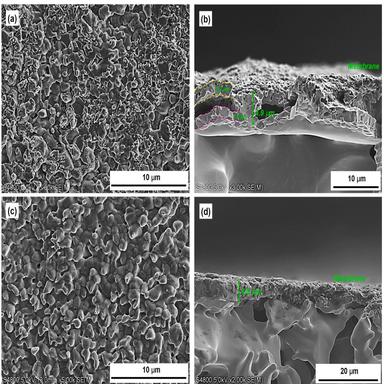
SEM micrographs of the membrane and cross section of samples prepared by middle powder with different sintered pressures, (a) and (b): 15 kPa; (c) and (d): 45 kPa.